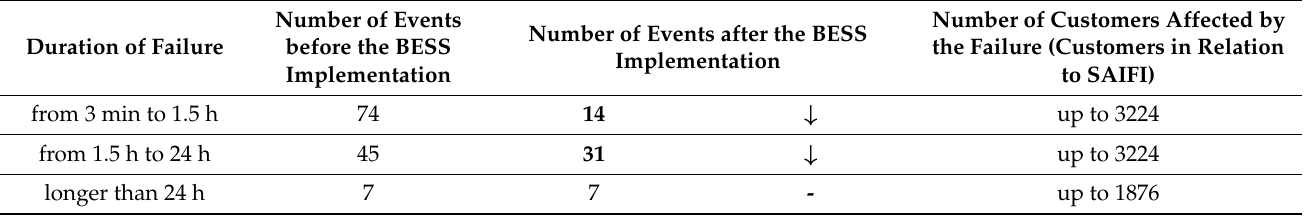
Table 16. Comparison of the number of power outages in the considered network before and after the BESS implementation. Number of Events Number of Customers Affected by Number of Events after the BESS Duration of Failure before the BESS the Failure (Customers in Relation Implementation Implementation to SAIFI) from 3 min to 1.5 h 74 14 ↓ up to 3224 from 1.5 h to 24 h 45 longer than 24